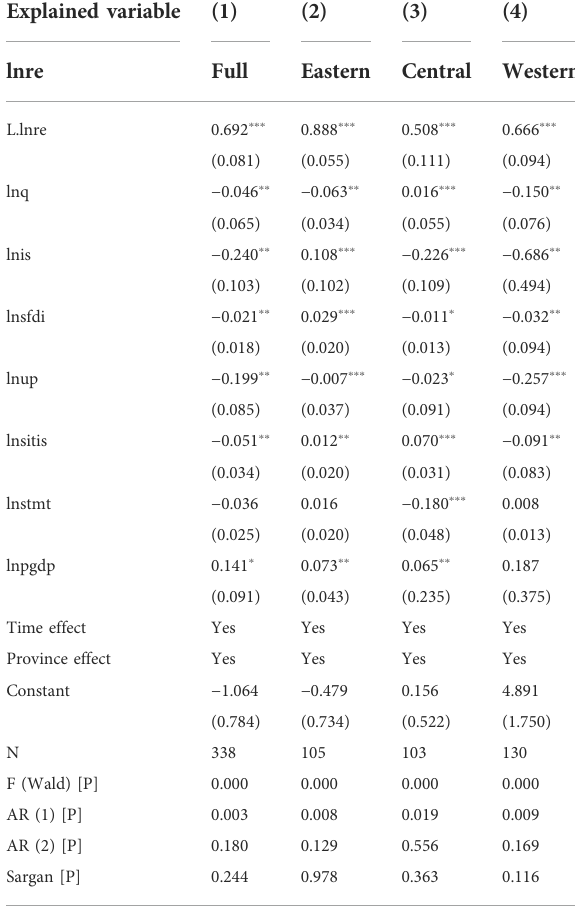
TABLE 1 Regional differences in the impact of urbanization spatial structure on rural sustainable development. Explained